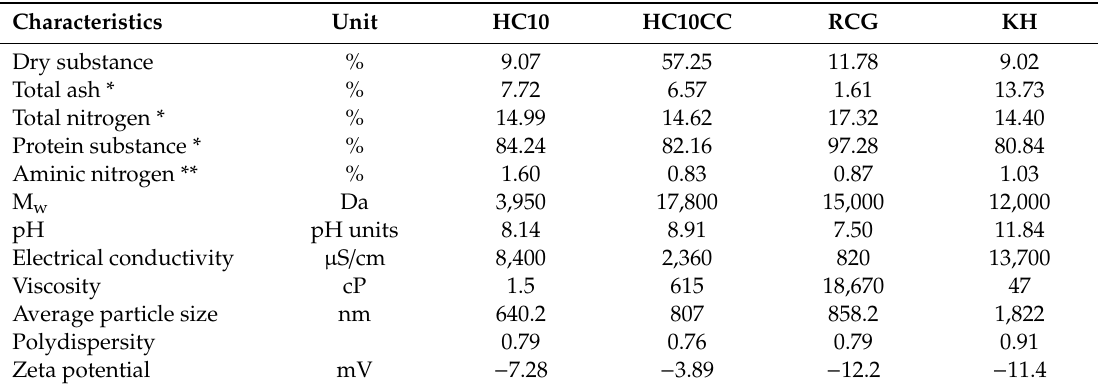
Table 2. Physical-chemical characteristics of collagen hydrolysate, concentrated collagen hydrolysate, rabbit collagen glue, and keratin hydrolysate extracts.